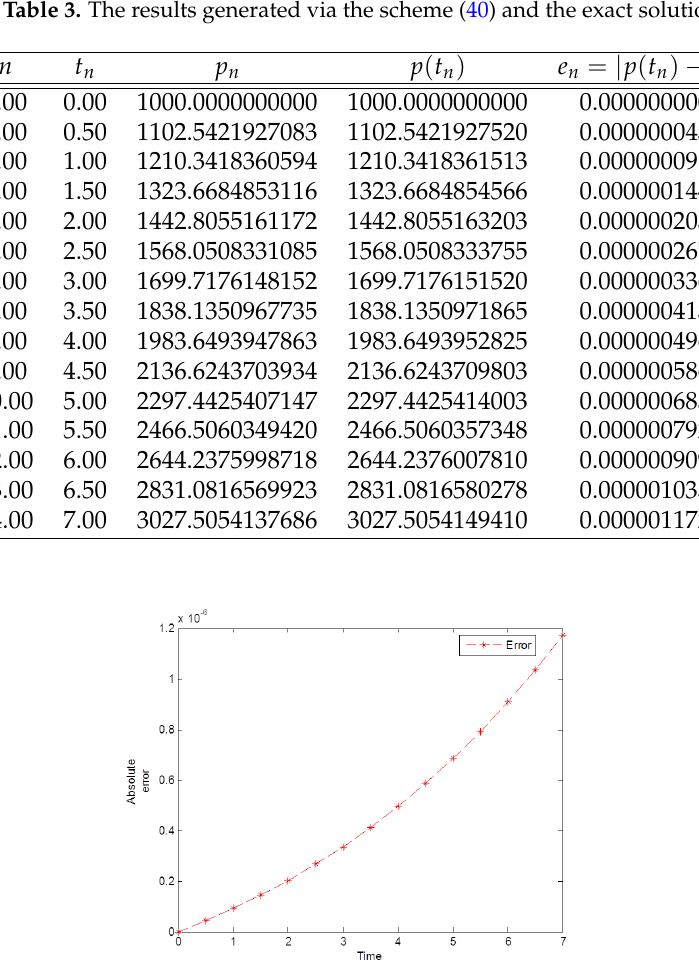
Table 3. Table 3. The results generated via the scheme (40) and the exact solution